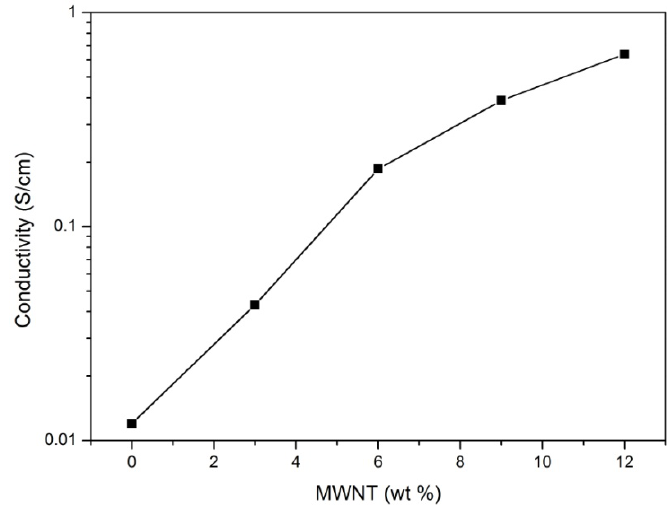
Figure 7. Variation of conductivity of the PPy/MWNT composite films for different MWNT concentration. The curve represents the best fit of the data to equation